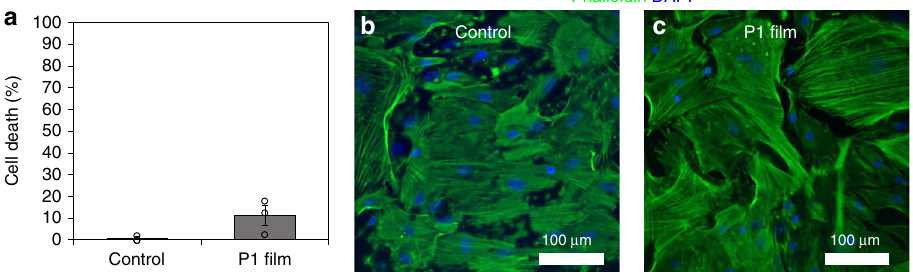
Fig. 10 P1 fi lm toxicity assessment. a Relative levels of LDH were measured to determine percent cell death of spinal cord astrocytes after cultured alone (control) or with P1 fi lms for 7 days. b , c Phalloidin (green) and DAPI (blue) staining were used to visualize spinal cord astrocytes after being cultured alone or with P1 fi lms for 7 days. ( n = 3, all values are mean ± std.